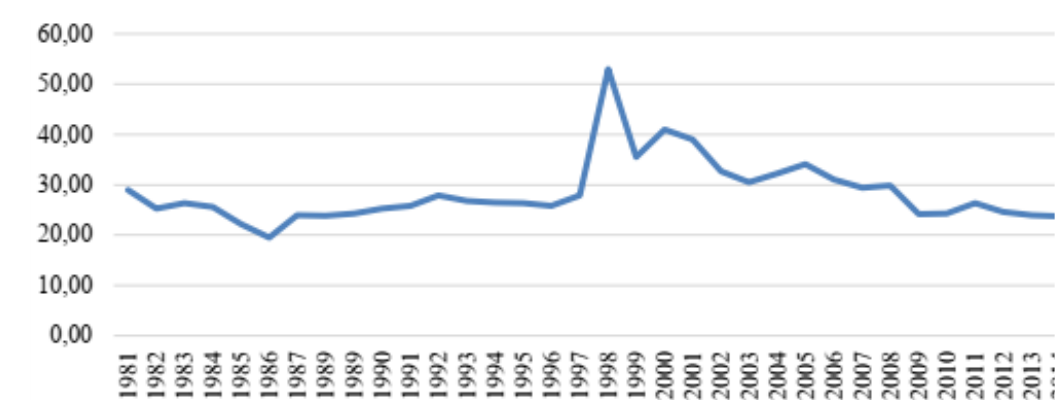
Figure 1: Exports (% of GDP) of Indonesia (1981-2014)